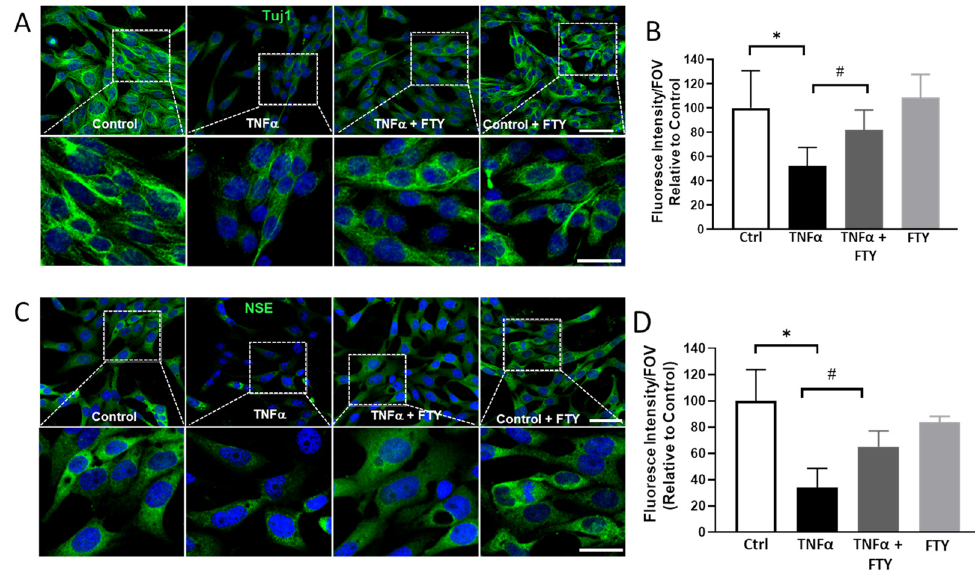
Figure 4. Fingolimod depicts protection against neuronal damage evidenced by immunofluorescence staining of marker proteins. ( A ) Representative confocal images showing the impact of TNF α treatment on neurofilament, Tuj1 ( β -tubulin class III) indicating neurodegeneration, which was reduced by co-treatment with FTY. High magnification images of the boxed areas, indicating reduced Tuj1 expression, are presented in the lower panel. Scale bar 50 µm. ( B ) Bar graph showing the quantification of Tuj1 level in response to TNF α treatment, and the protective effect by co-treatment with FTY ( C ) Representative confocal images showing the changes in neuronal enolase (NSE) in response to TNF α and FTY treatments. Lower panel show high magnification images of the boxed areas, indicating reduced levels in TNF α treated group and the improved NSE expression in response to FTY co-treatment. Scale bar 50 µm. ( D ) Bar graph showing the quantification of Tuj1 and NSE levels in response to TNF α treatment, and the effect by co-treatment with FTY [* p < 0.01 vs. control; # p < 0.01 vs. TNF α , n = 3 per group].